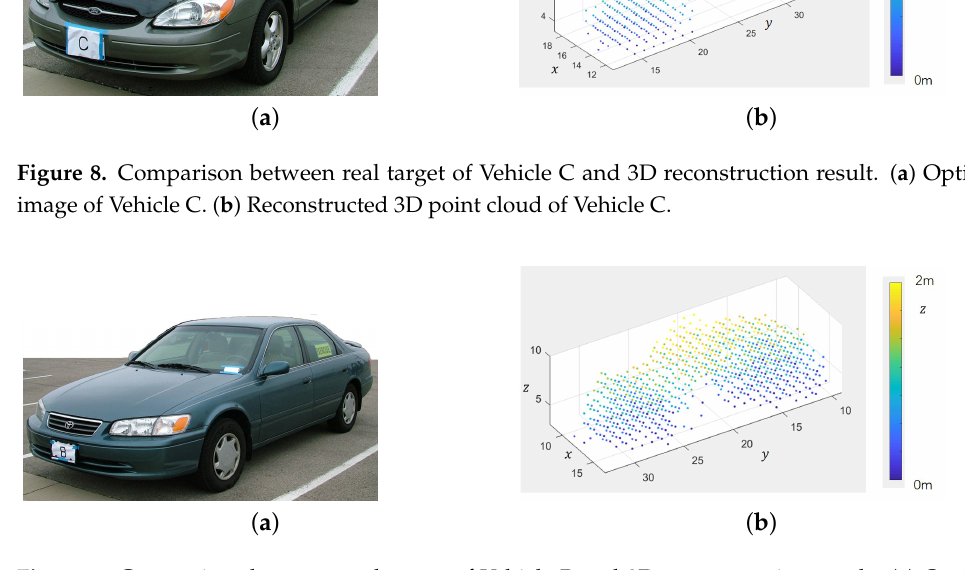
Figure 9. Comparison between real target of Vehicle B and 3D reconstruction result. ( a ) Optical image of Vehicle B. ( b ) Reconstructed 3D point cloud of Vehicle